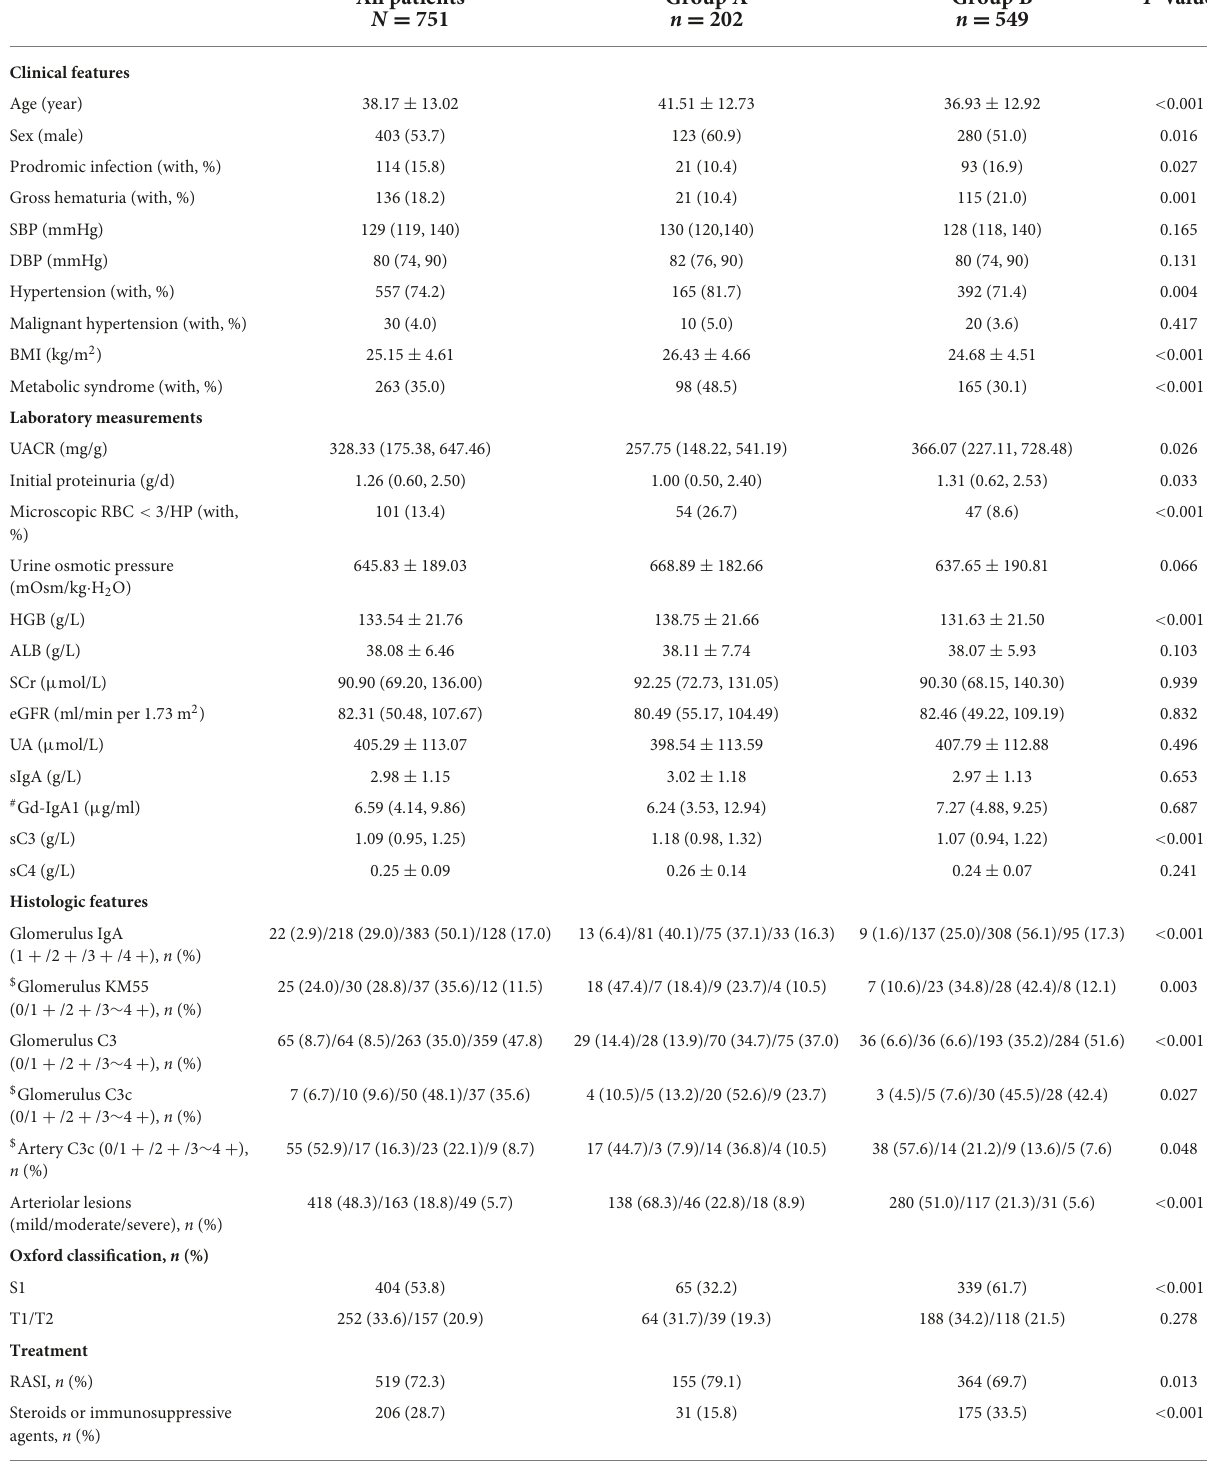
TABLE 1 Demographic, clinical, and histologic characteristics of patients with